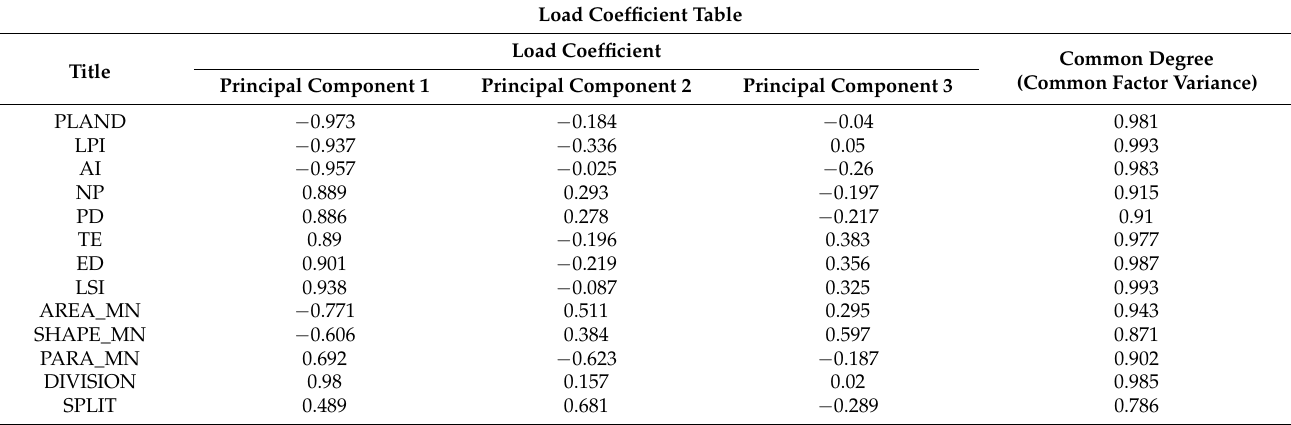
Table 3. Relationship table between principal components and landscape pattern indices.